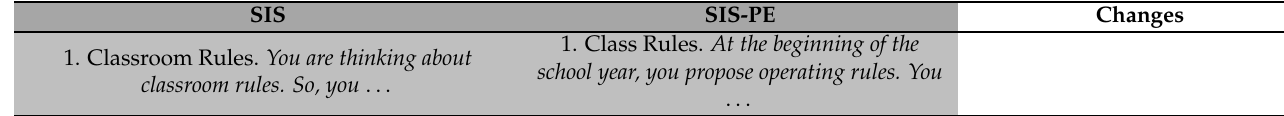
Table 2. Similarities and differences between SIS and SIS-PE